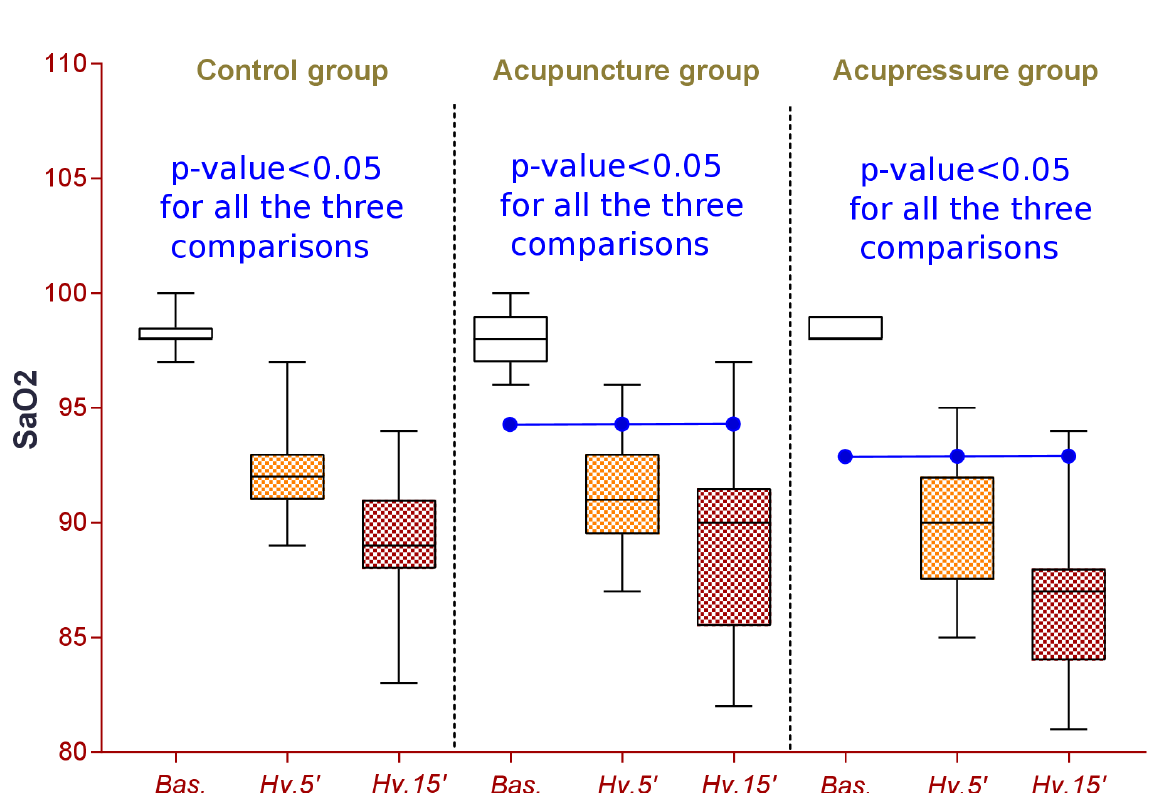
Figure 4. Descriptive analysis for percentage of oxyhaemoglobin saturation (SaO 2 ) in control, acupuncture, and band (acupressure) groups at baseline and after 5 and 15 min of hypoxia.